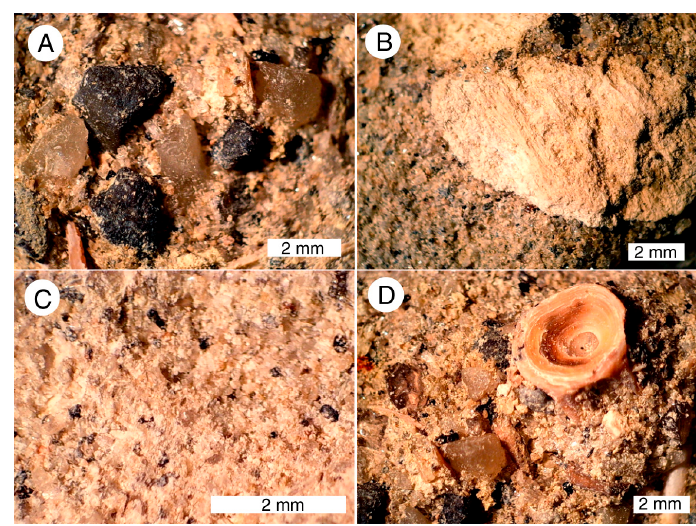
Figure 7. Bruneau Woodpile sedimentology. ( A , B ) are sediments from wood-bearing stratum. ( A ) Black obsidian granules and translucent gray quartz grain; ( B ) Pumice clast; ( C ) fine-grained ash-rich bed that overlies wood-bearing stratum; ( D ) fish vertebra in sandy sediment containing quartz and obsidian granules.